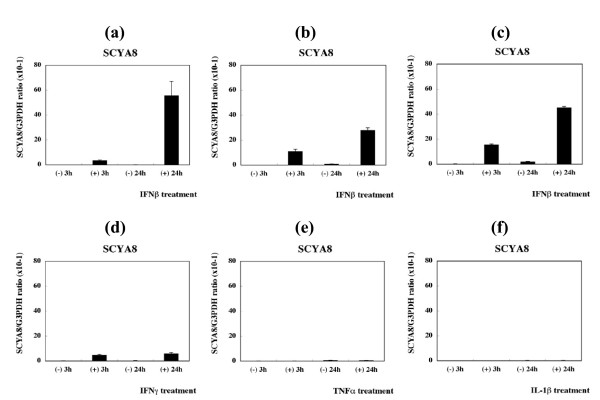
Real-time RT-PCR analysis of SCYA8 expression in PBMC. See the footnote of Figure 1. The panels represent the expression of SCYA8 in (a) #1, IFNβ; (b) #2, IFNβ; (c) #3, IFNβ; (d) #1, IFNγ; (e) #1, TNFα; and (f) #1, IL-1β.